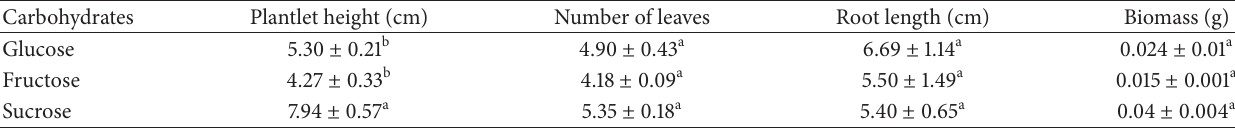
Table 3: Bambara groundnut plantlets growth on 1/2 MS containing glucose, sucrose, and fructose. Carbohydrates